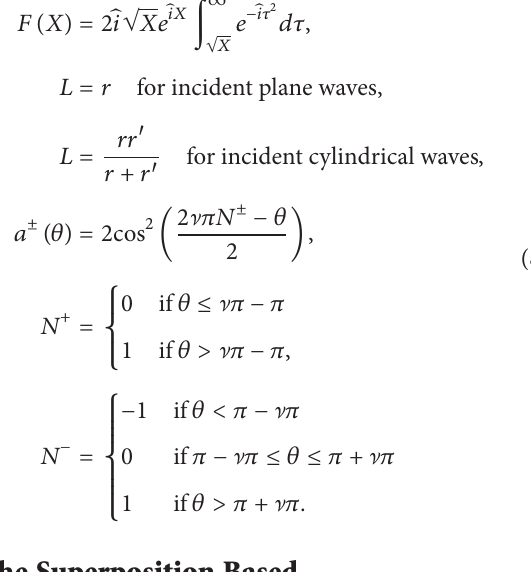
application of the expression given in (7) with the values